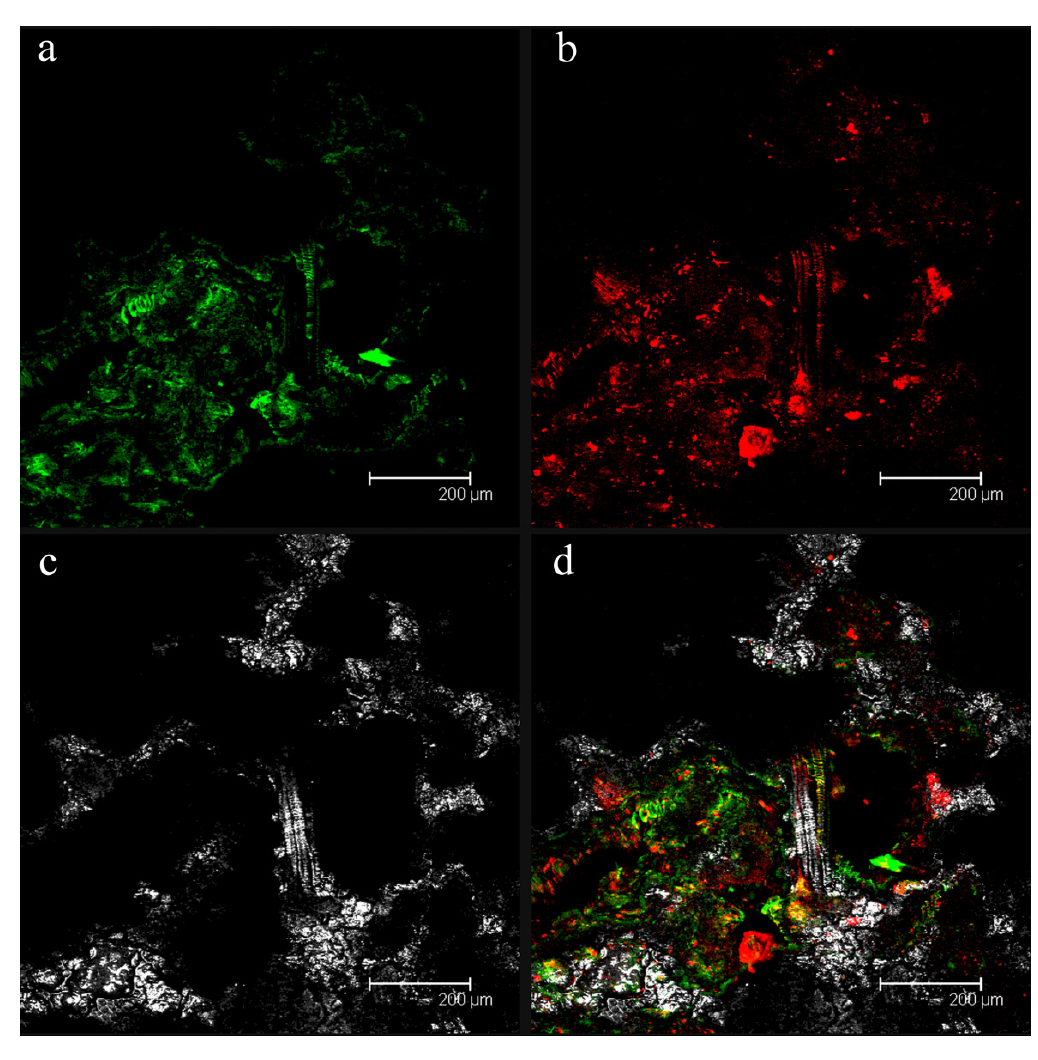
Figure 1. Confocal analysis of the biofouling on the filtration membrane of the Aldeno membrane bioreactor (MBR) wastewater treatment plants (WWTP). ( a ) bacterial cells (green fluorescence); ( b ) the biofilm exopolysaccharides in the matrix (red fluorescence); ( c ) the membrane fibers in reflection mode; ( d ) the superimposition of panels ( a ), ( b ) and ( c